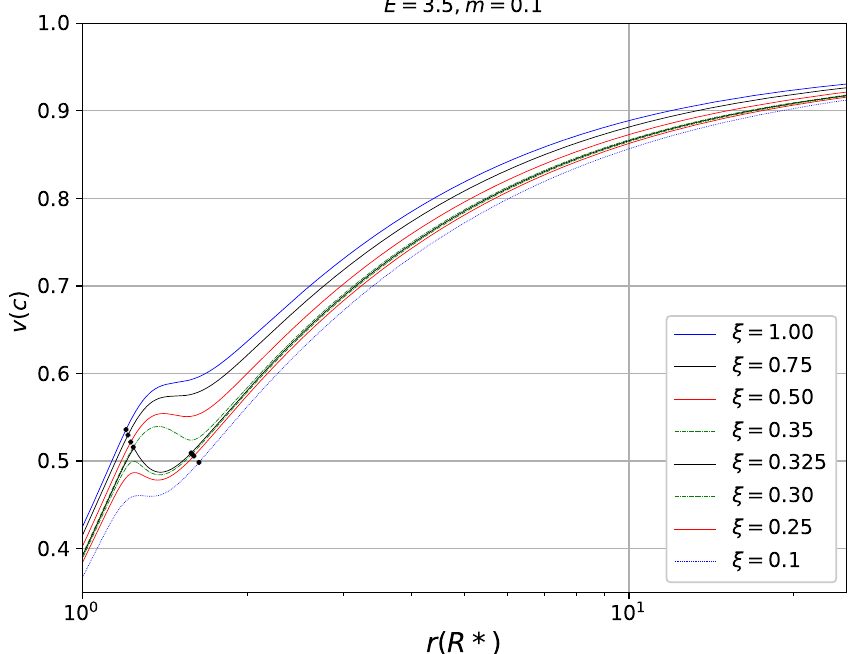
Figure 8. Jet velocity profiles for collimation parameter m = 0.1 and E = 3.5 for different choices of ξ in range 0.1–1. Curves with decreasing vertical position represent a decreasing value of ξ . No shock solutions are found as the collimation is